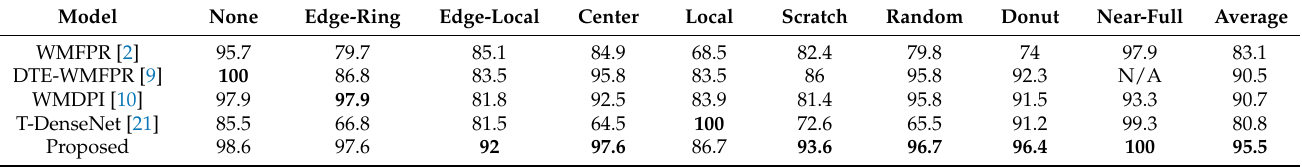
Table 5. Comparison with classical wafer map defect pattern classification algorithms